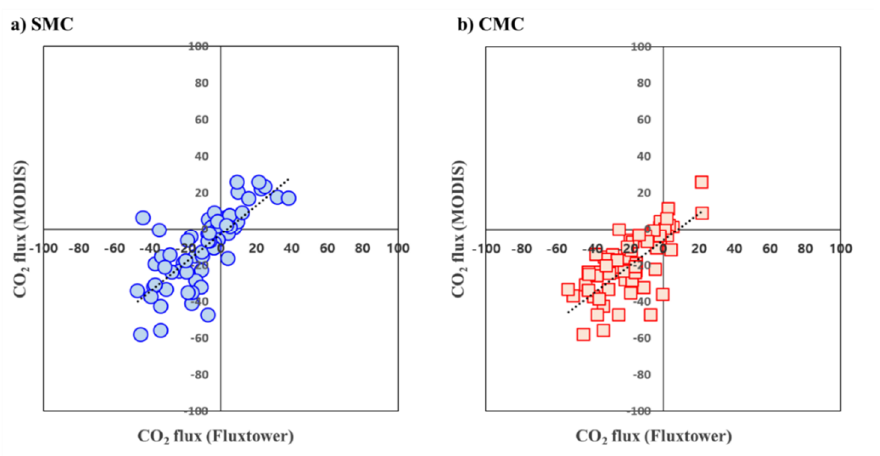
Figure 4. Temporal variations of average eight-day CO 2 flux at at a ) SMC and b ) CMC site.